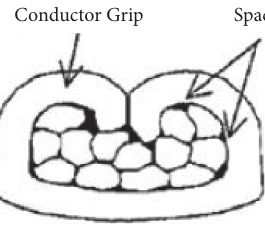
Figure 9: Crimp cross section.